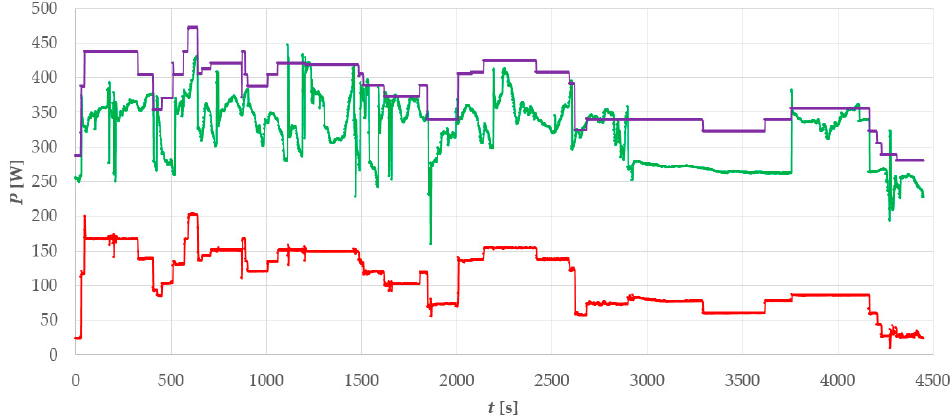
Figure 10. The microgrid: The patterns describing the power supplied and taken off (red—the power consumption with demand response disabled; violet—the power consumption with demand response activated; green—power supplied by all sources).